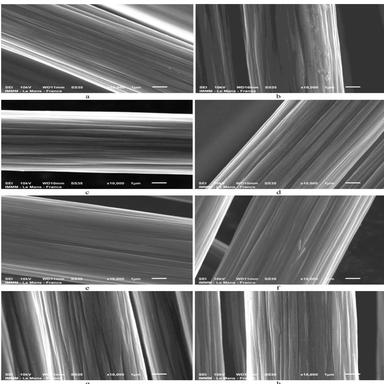
SEM pictures (magnification ×10k) of T300 CF a) untreated, and plasma treated: b) Ar 100 W, 5 min; O2 treated: c) 40 W, 1 min; d) 40 W, 10 min; e) 10 W, 5 min; f) 40 W, 5 min; g) 50 W, 5 min; h) 100 W, 5 min.